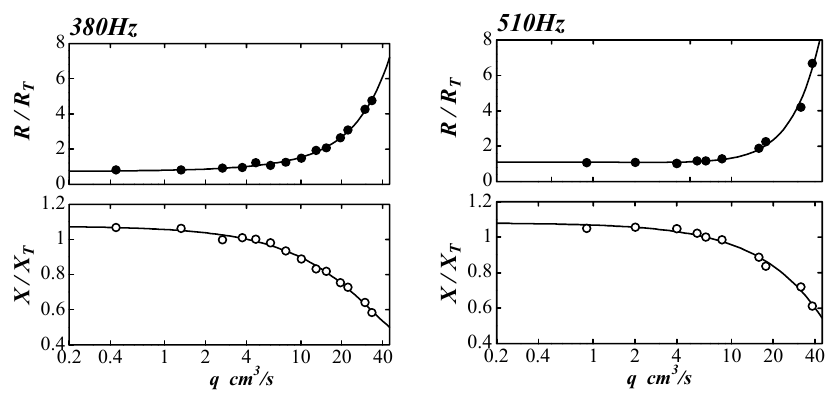
The solid loops show the